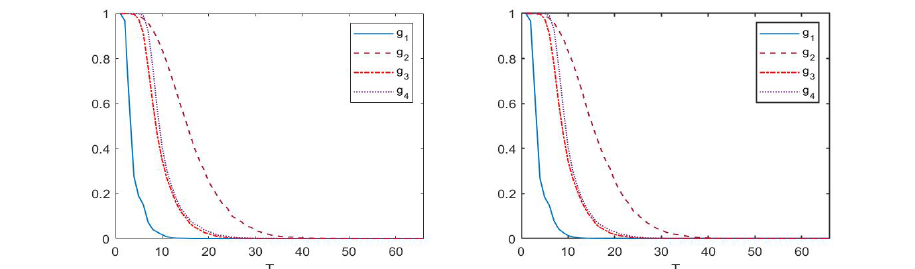
Figure 2. The converge rates of five test statistics under H 1 , against the length of time interval T . ( Left ): a 90% nominal level. ( Right ): a 95% nominal